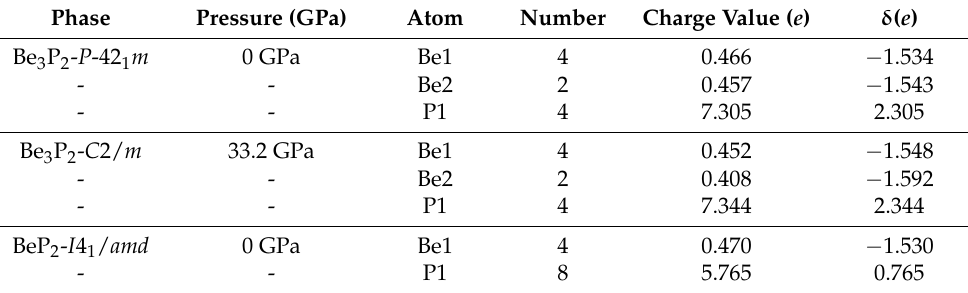
Table 1. The Bader charge transfer of Be 3 P 2 − P − 42 1 m , Be 3 P 2 − C 2/ m , and BeP 2 − I 4 1 / amd